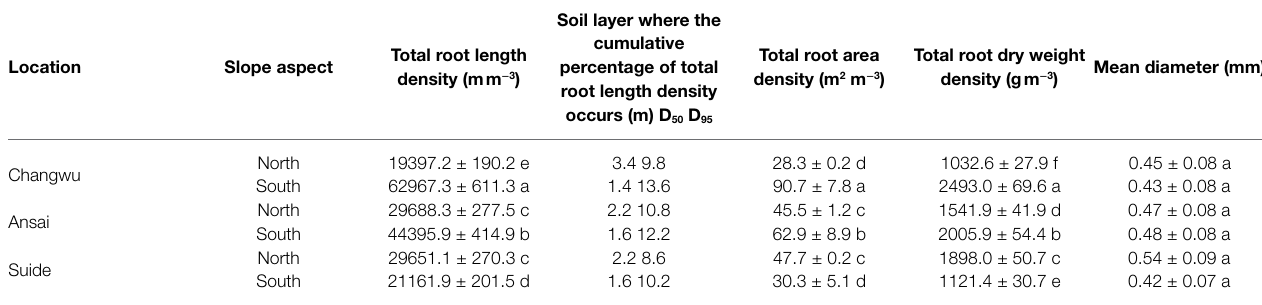
Different lowercase letters for total root length density, total root area density, total root dry weight density, and mean diameter indicate significant differences among sampling sites on different slope aspects (n = 3, p <